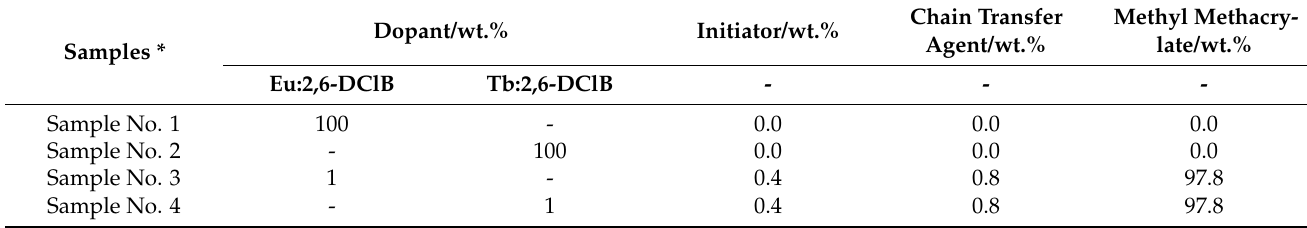
Table 1. Experimental parameters of the syntheses—polymer matrix